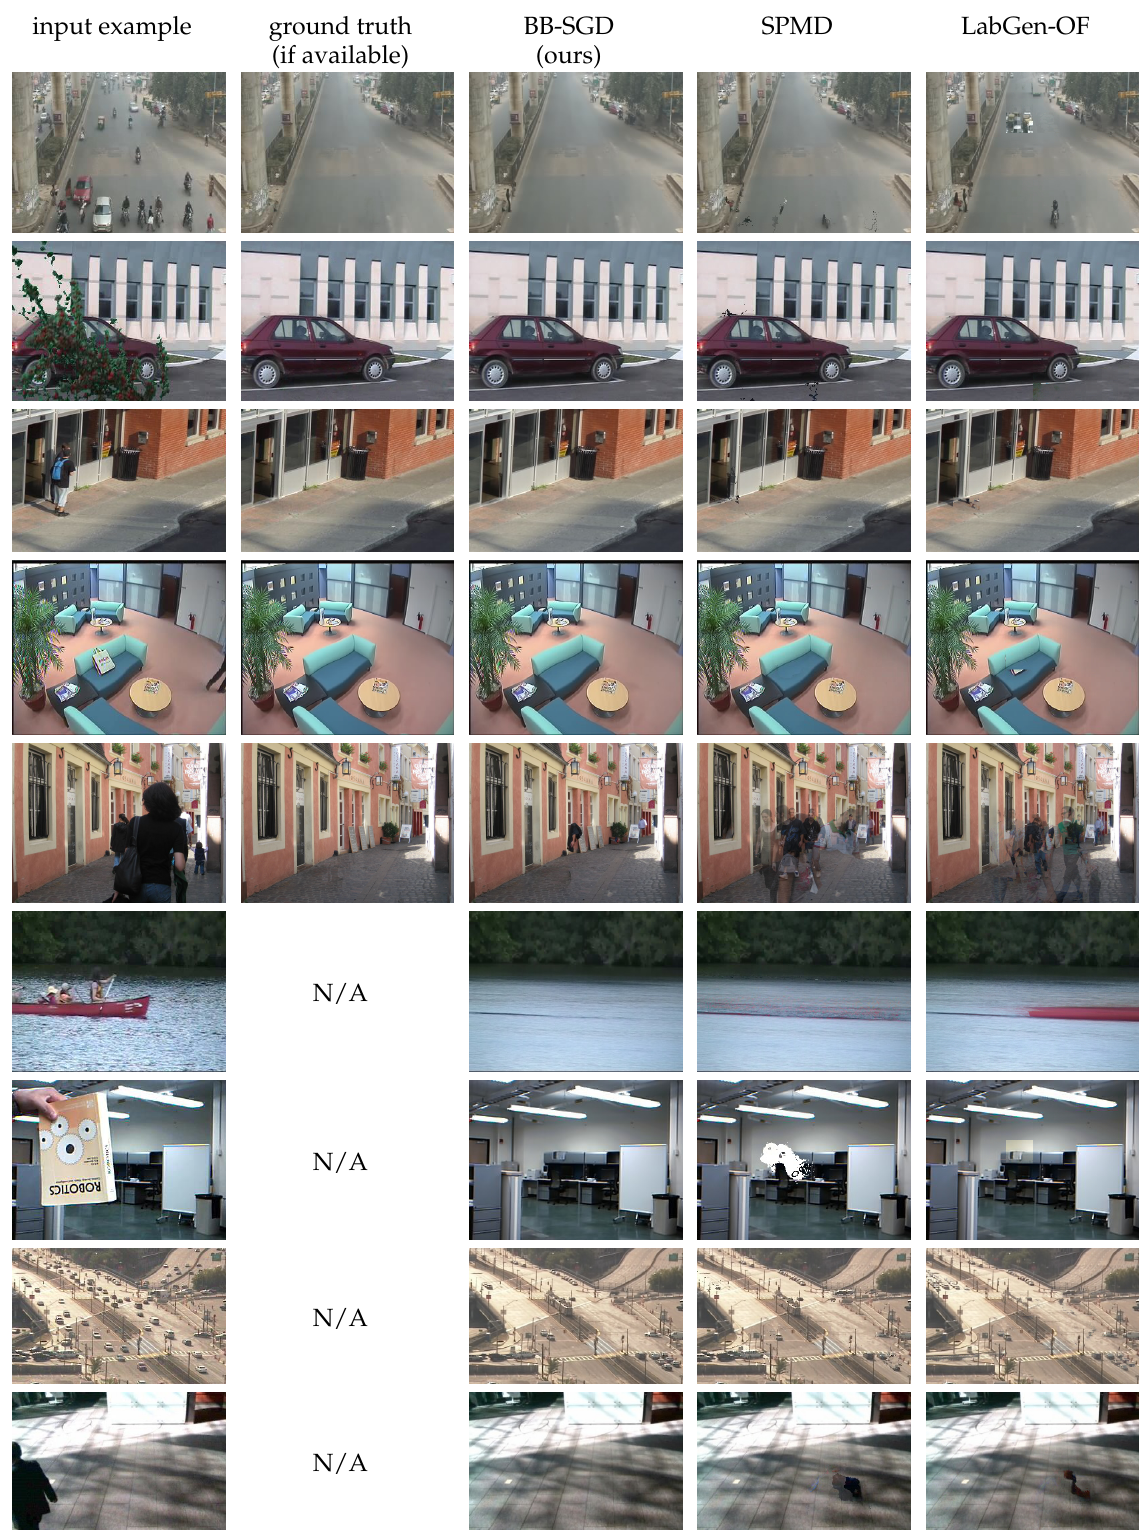
Figure 3. Examples of background reconstruction using the proposed model and comparison with SPMD and